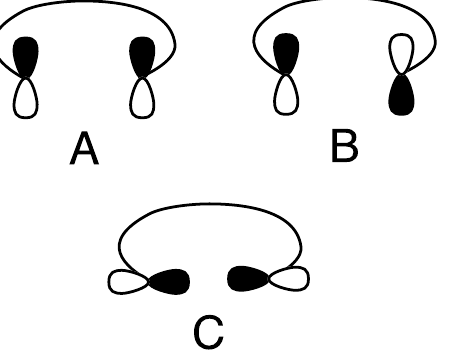
Figure 5. Three representations of the orbitals on the terminal ends of simplified molecules with double bonds. All other bonds and orbitals have been reduced to the curved line. (A) and (B) show the two possible orientations of the terminal orbitals, and (C) shows a correct overlapping of the orbitals to form a bond.